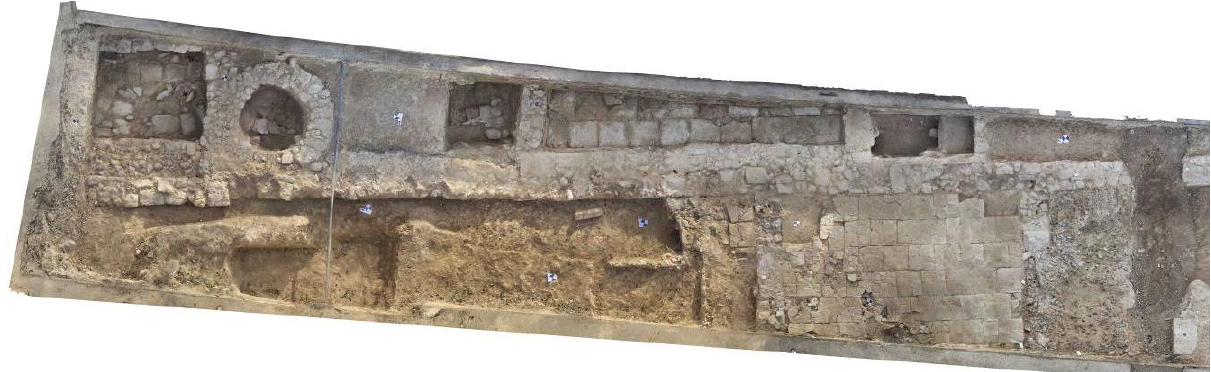
Figure 7: St. Francis Street Excavation, Larnaca, Orthophoto, Detail